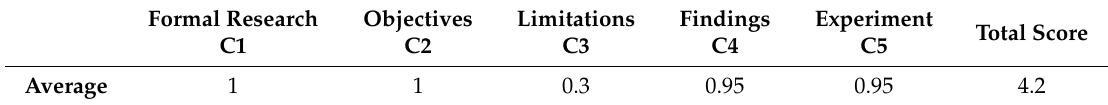
Table 11. Average of assessment